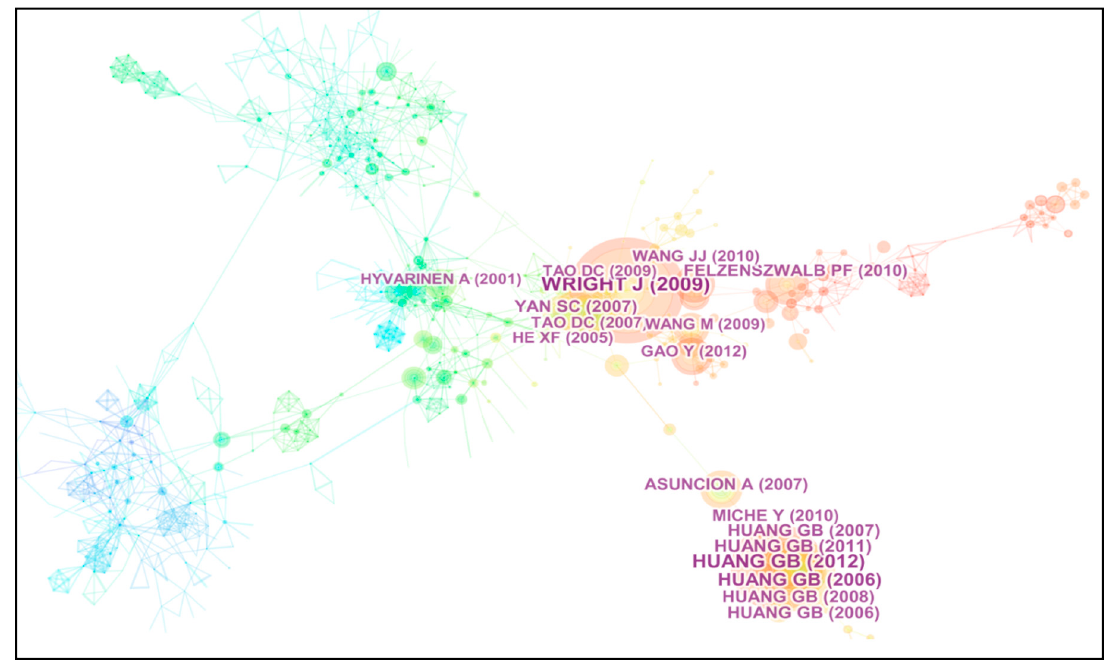
Figure 10. Document co-citation analysis.